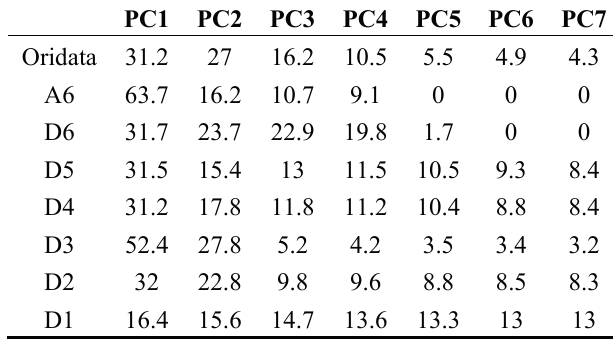
Table 1. Explanation of the Variance from the EOF of the Decomposed Result (%).